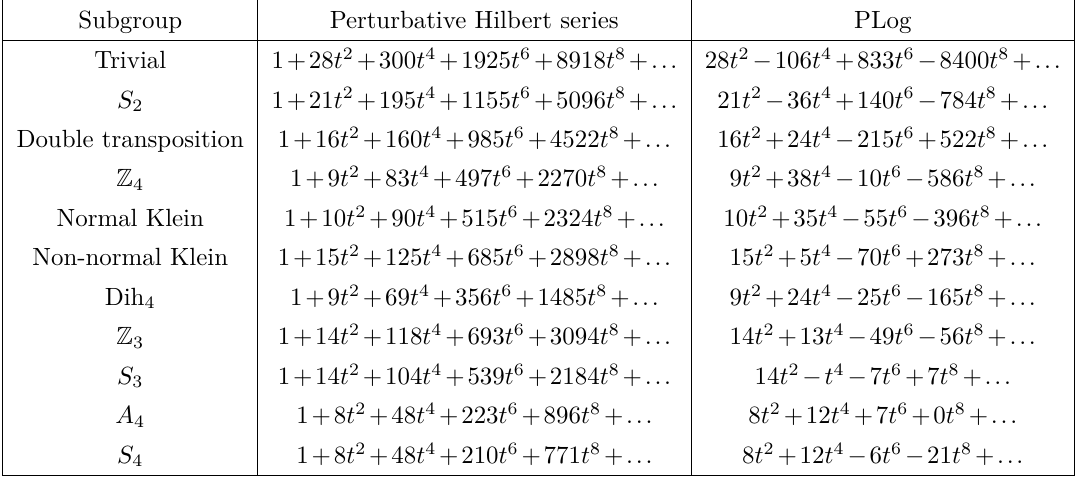
Table 5 . Wreathed quivers obtained from the affine D 4 quiver by acting on the legs by all subgroups of S 4